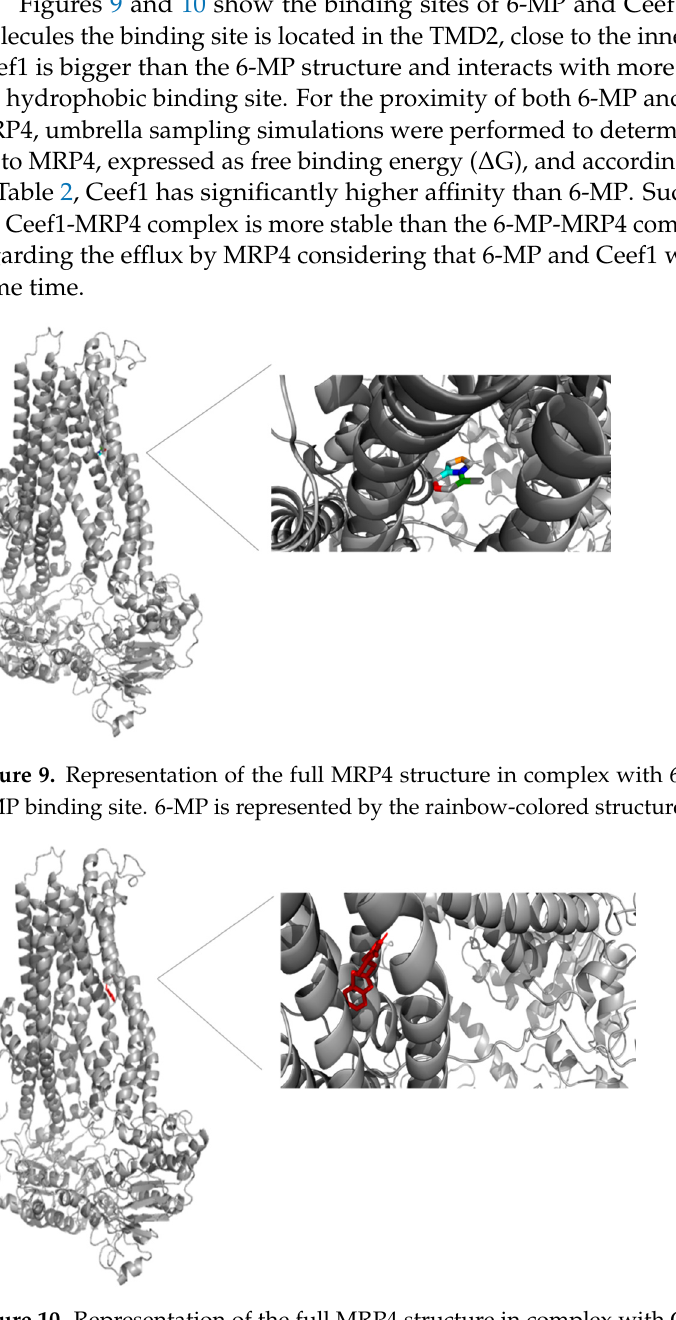
Figure 10. Representation of the full MRP4 structure in complex with Ceef1, and a close up to the 6-MP binding site. Ceef1 is represented by the red structure.